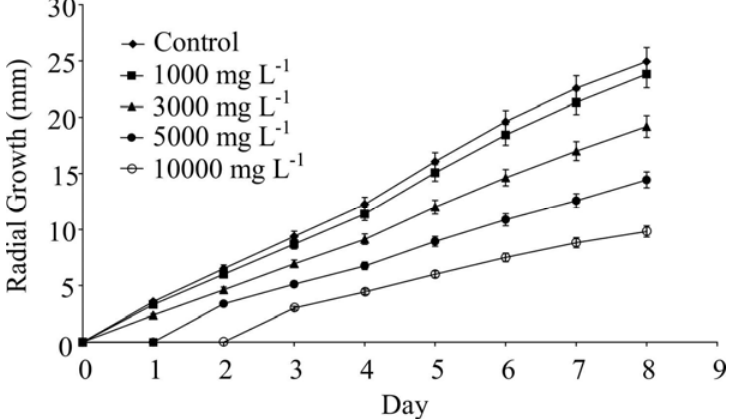
Figure 3. Radial culture growth of C. cassiicola in culture medium containing L.